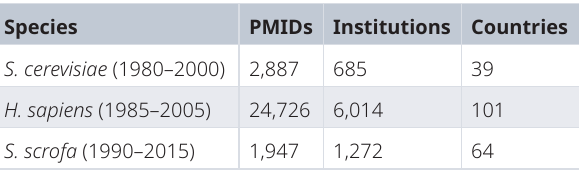
Table 2. Total number of PMIDs, institutions, and countries extracted from SCOPUS for S. cerevisiae (1980–2000), H. sapiens (1985–2005) and S. scrofa